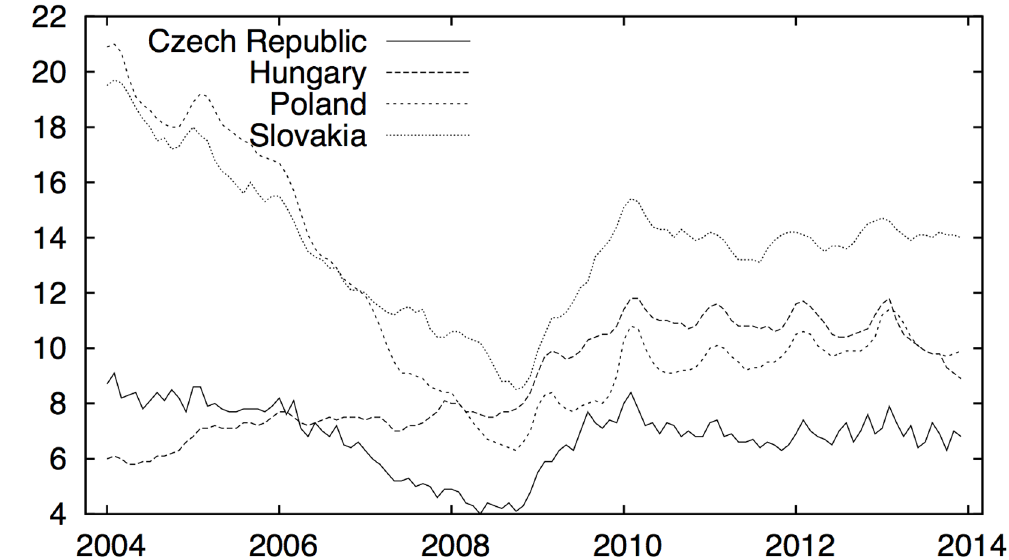
Fig 1. Unemployment rate in the Visegrad countries. The group of countries is evidently quite heterogenous in the unemployment rates. The Hungarian rate starts at the lowest level but increases stably during the whole period. The Czech rate begins at quite low levels and decreases up to the outbreak of the financial crisis when the rate surges up until 2010, after which it remains quite stable. The Polish and Slovakian rates commence at very high levels of unemployment, which decrease again up until the outbreak of the crisis, after which they change trends, similarly to the Czech rate.